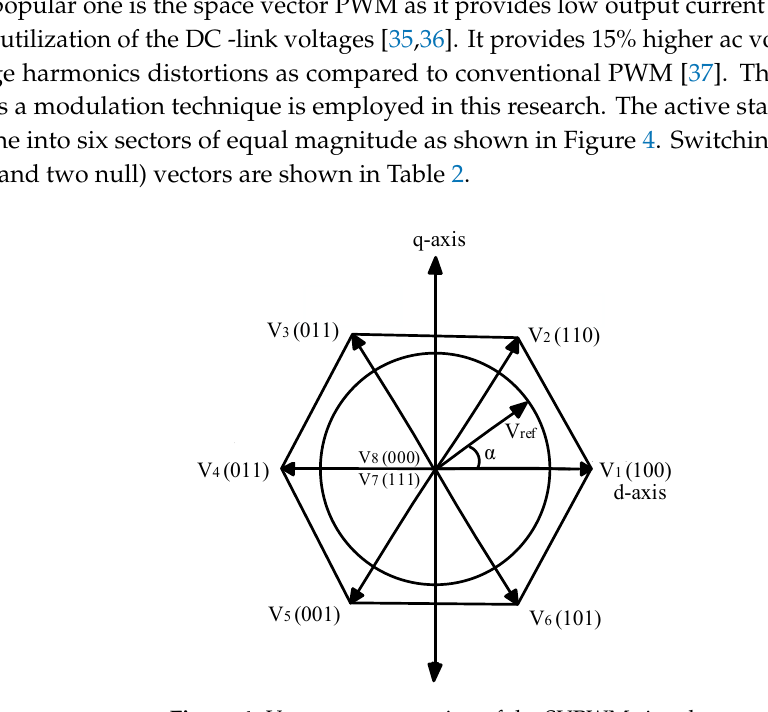
T 2 /T s ×V 2 Figure 5. Vector representation of the SVM signal in sector 1 . Table 2. Space vectors state and the switching sequence. Vector